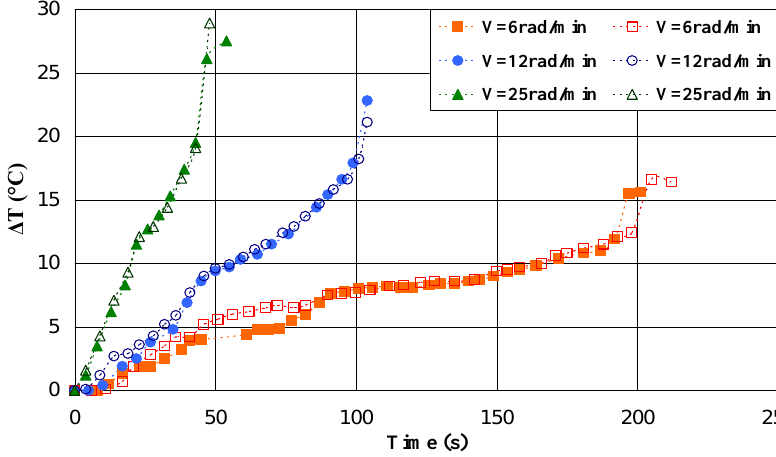
Figure 19. Self-heating of PC induced by torsion